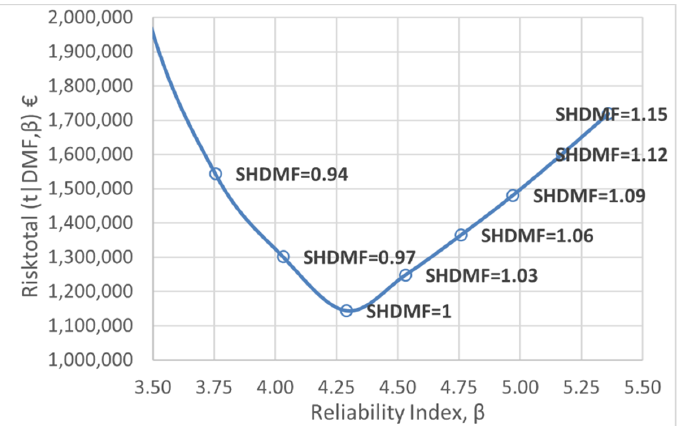
Figure 6. Expected total